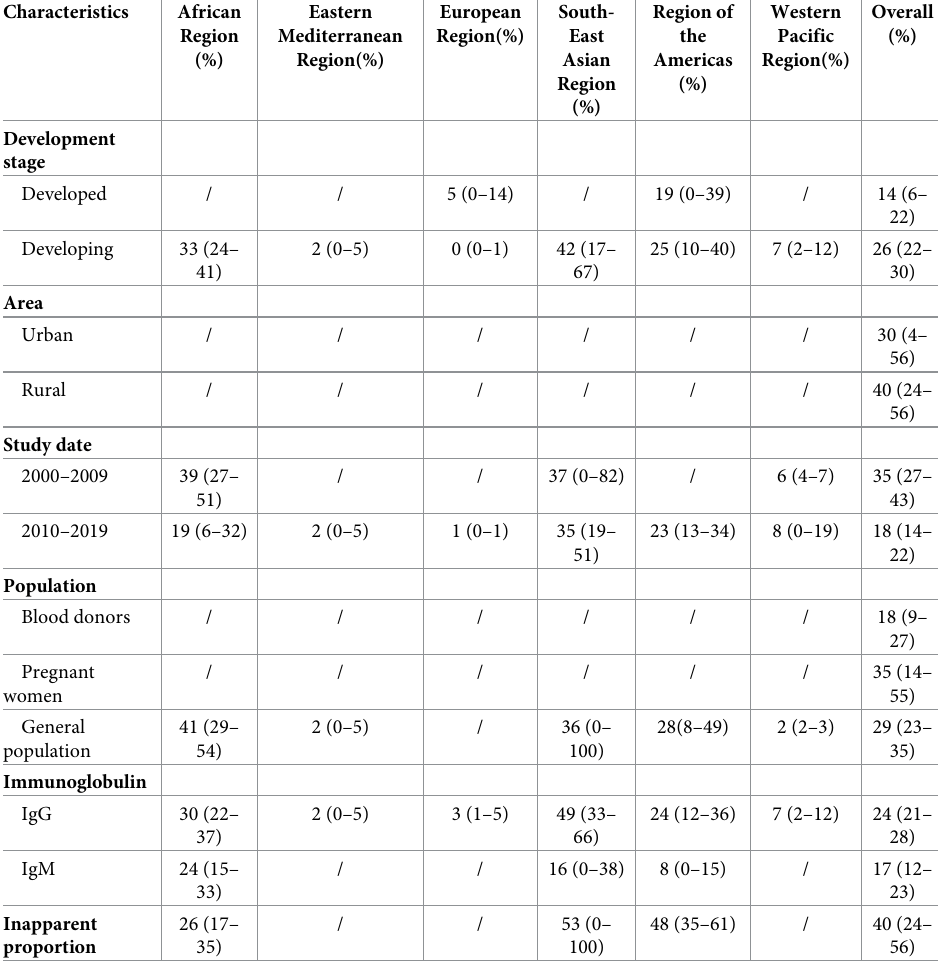
Table 3. Seroprevalence of CHIKV infection and subgroup